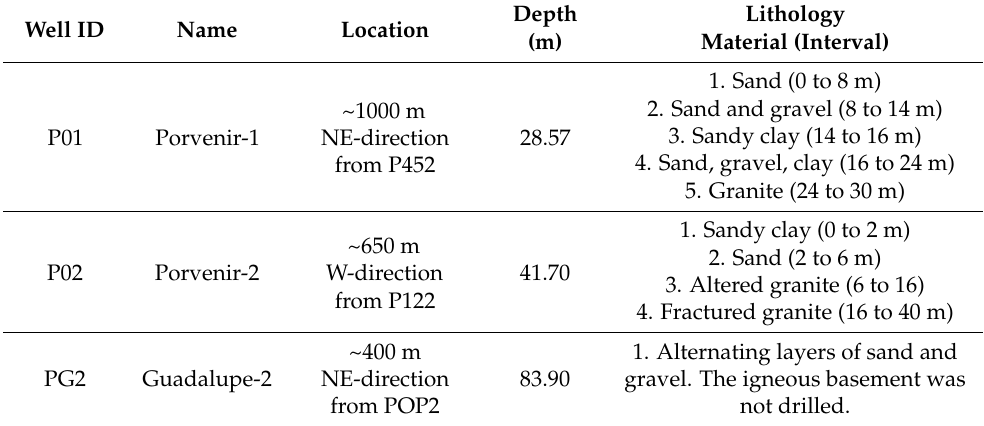
Table 2. Summary of the characteristics of the reference wells included as a part of this study.